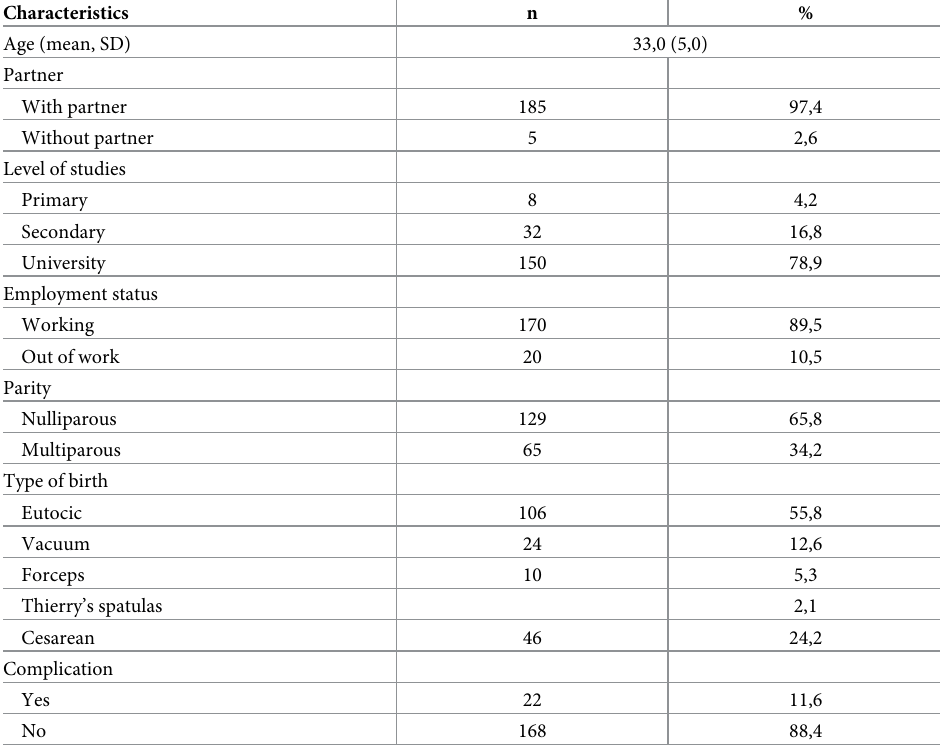
Table 1. Sociodemographic and clinical characteristics of the study sample.